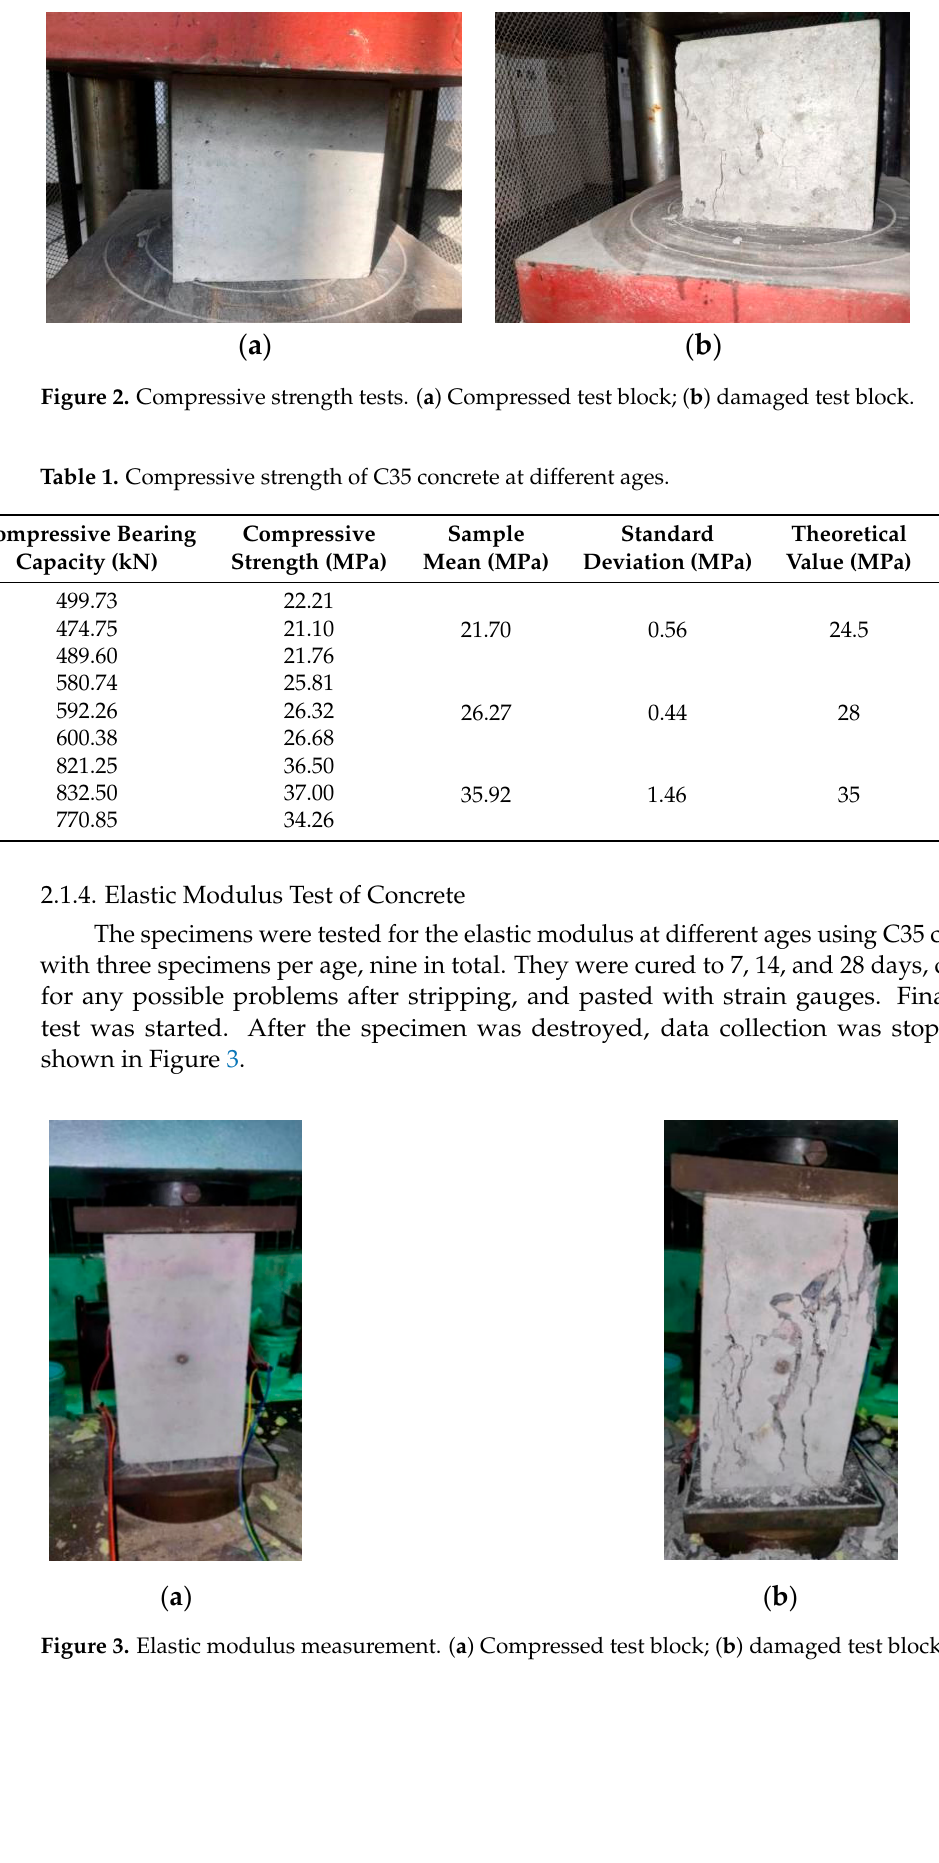
Figure 2. Compressive strength tests. ( a ) Compressed test block; ( b ) damaged test block.